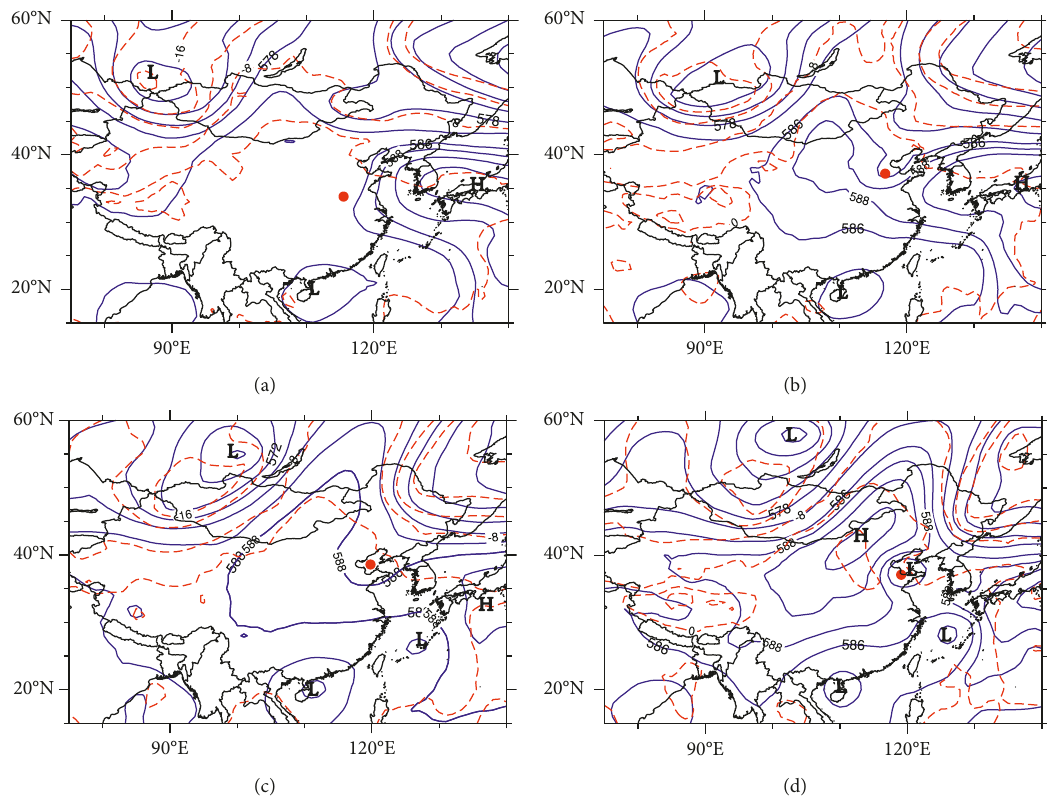
Figure 6: 500hPa circulation patterns: (a) 0000 UTC 14 August; (b) 1200 UTC 14 August; (c) 0000 UTC 15 August; (d) 1200 UTC 15 August. The blue contours represent the GPH (gpm), the red contours represent the temperature (K), and the red dots represent the location of